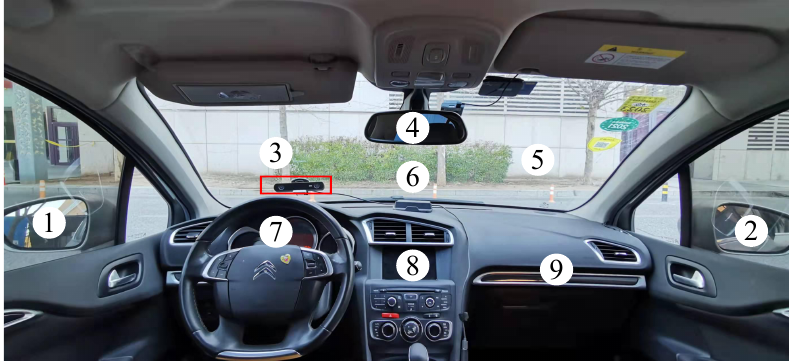
Figure 6. Gaze zone partition in the naturalistic driving condition.